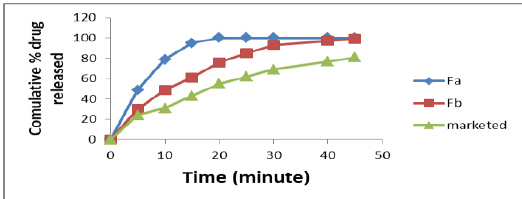
Figure 3. Dissolution profile of prepared tablets and mirtazapine marketed in buffer (pH 1.2) at 50 r.p.m and 37ºC .